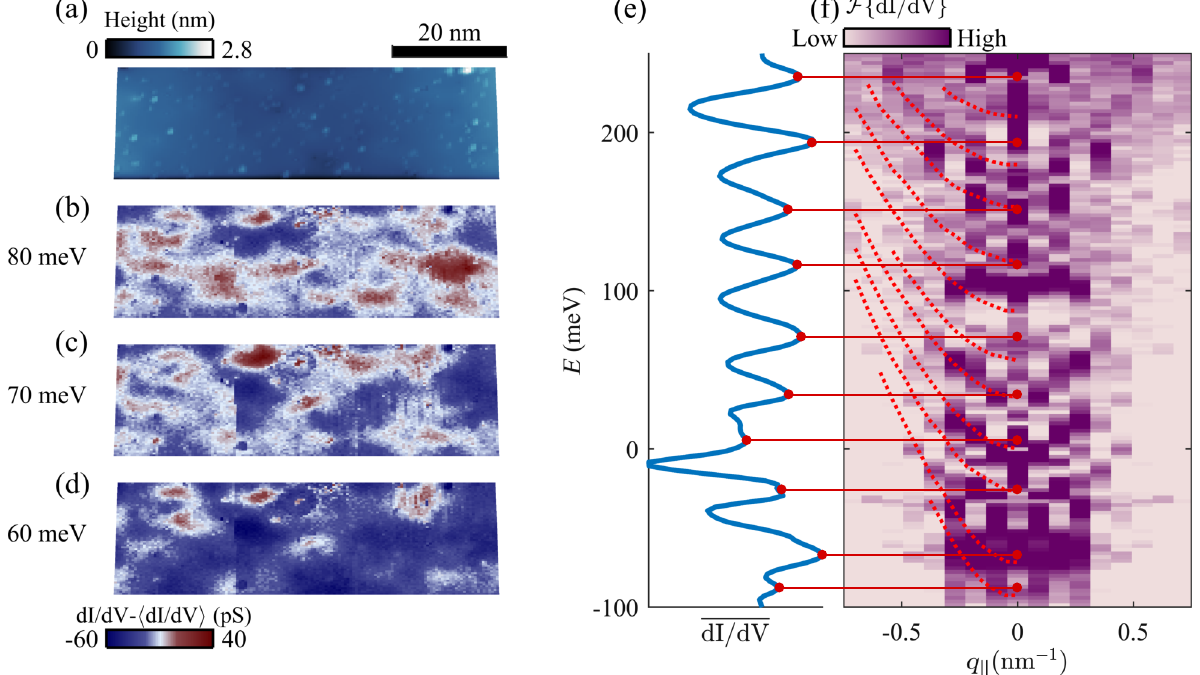
FIG. 11. Quasiparticle interference imaging of the quantized bands in InAs nanowires. (a) Topography of the nanowire surface with various surface impurities that serve as scattering centers. The horizontal direction is parallel to the direction of the nanowire. (b) – (d) Differential conductance (dI/dV) maps at 80, 70, and 60 meV, showing dispersive QPI patterns manifested in spatial fluctuation around the mean value at each energy. Comparing the spatial standard deviation of the LDOS to the mean spectrum shows that roughly 5% of the LDOS is modulated. (e) Mean spectrum showing van Hove singularities. The spectrum was obtained by spatially averaging the dI/ dV maps and subtracting a monotonic smooth background for visibility. (f) Fourier transform of the dI/dV maps with respect to the direction of the nanowire. The red dotted curves are copied from Fig. 10 (the x axis was scaled to represent momentum transfer q ¼ 2 k ) and demonstrate the close resemblance between the calculated and the measured band structures. The solid red lines indicate that the bottom of each band originates from a specific van Hove